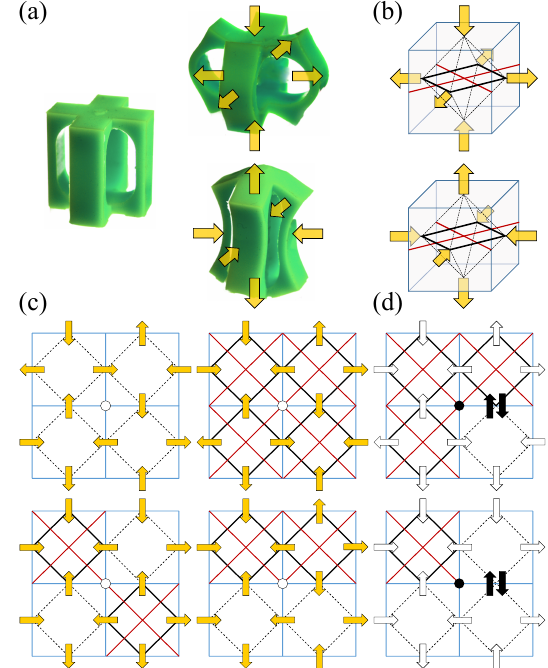
Figure 6: (a) 3D cubic building block and its soft deformation mode (adapted from Ref. [ 10 ] ). (b) Deformation sign between two adjacent facets is preserved (flipped) if deformations wind in the same (opposite) direction with respect to the common edge between them. Ferromagnetic sign-preserving (antiferromagnetic sign-flipping) interactions are indicated by dashed (solid) lines connecting the two facets. A red cross drawn perpendicular to the sign-flipping interactions designates the orientation of the building block. (c) Top view of a compatible and (d) an incompatible edge consisting of an even (odd) number of antiferromagnetic interactions, as indicated by white (black) circle. The number of antiferromagnetic interactions can be inferred from the parity of red lines meeting at the central